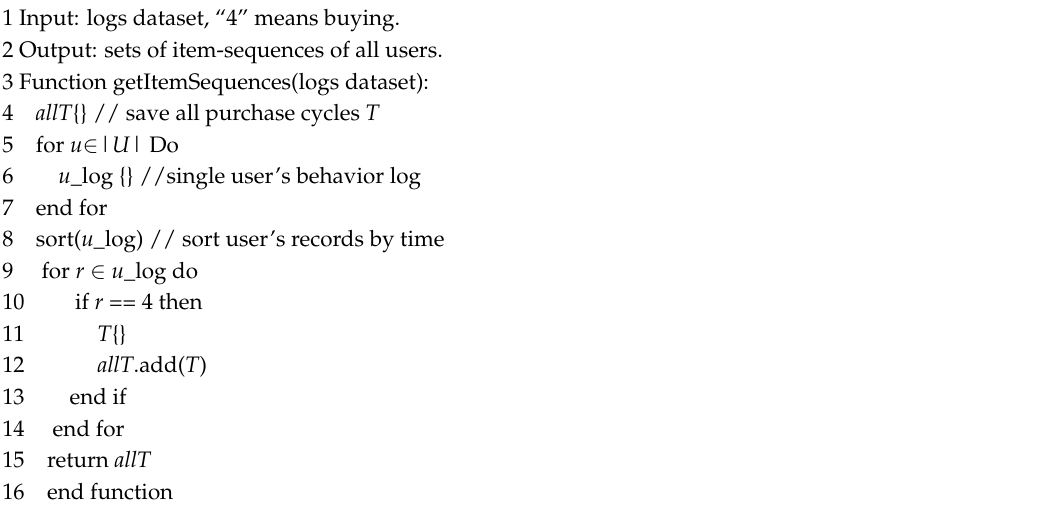
Algorithm 1: The algorithm for extracting the